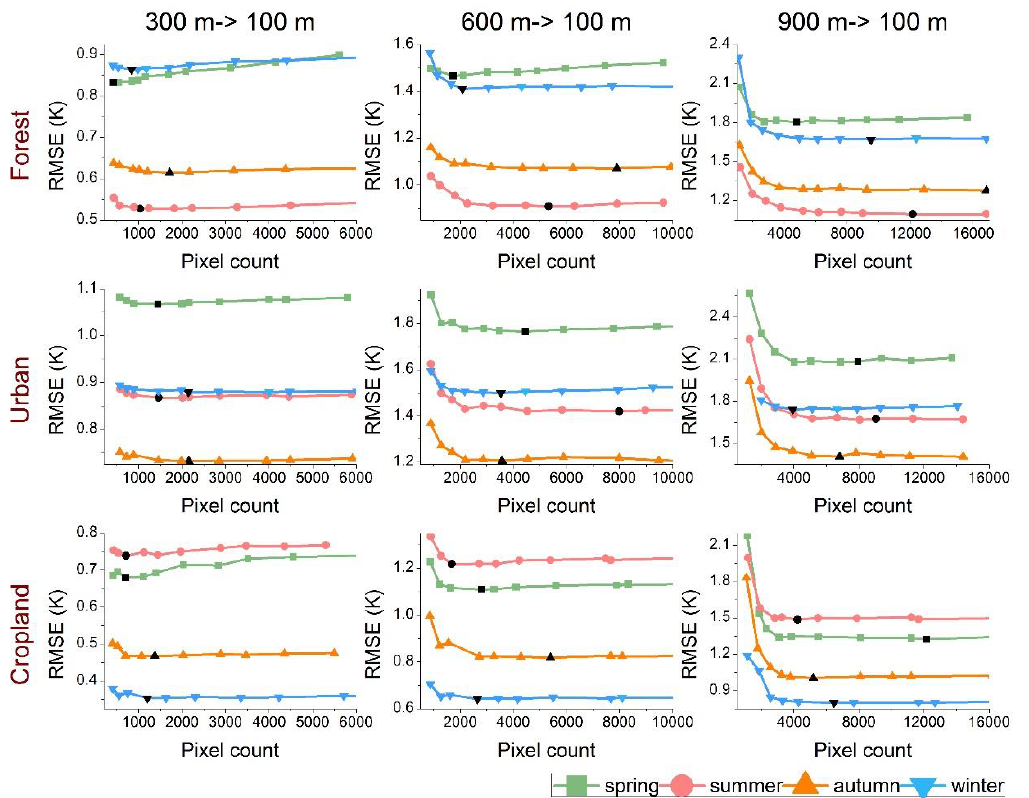
Figure 4. RMSEs of the OWS at different segmentation scales. The x-axis is the pixel count in an object-based window and represents the segmentation scales. The black point indicates the minimum RMSE value.